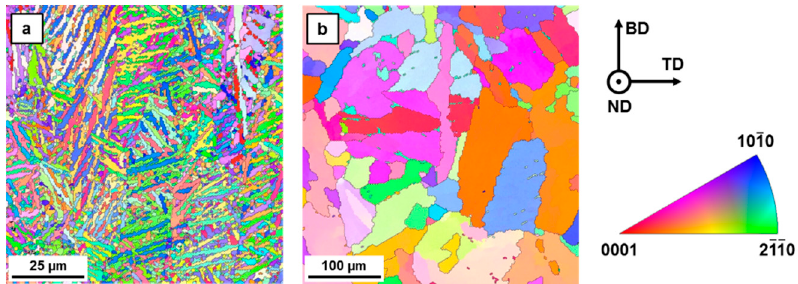
Figure 6. EBSD IPF maps for Ti6Al4V in ( a ) the as-built and ( b ) the heat-treated condition, recompiled from